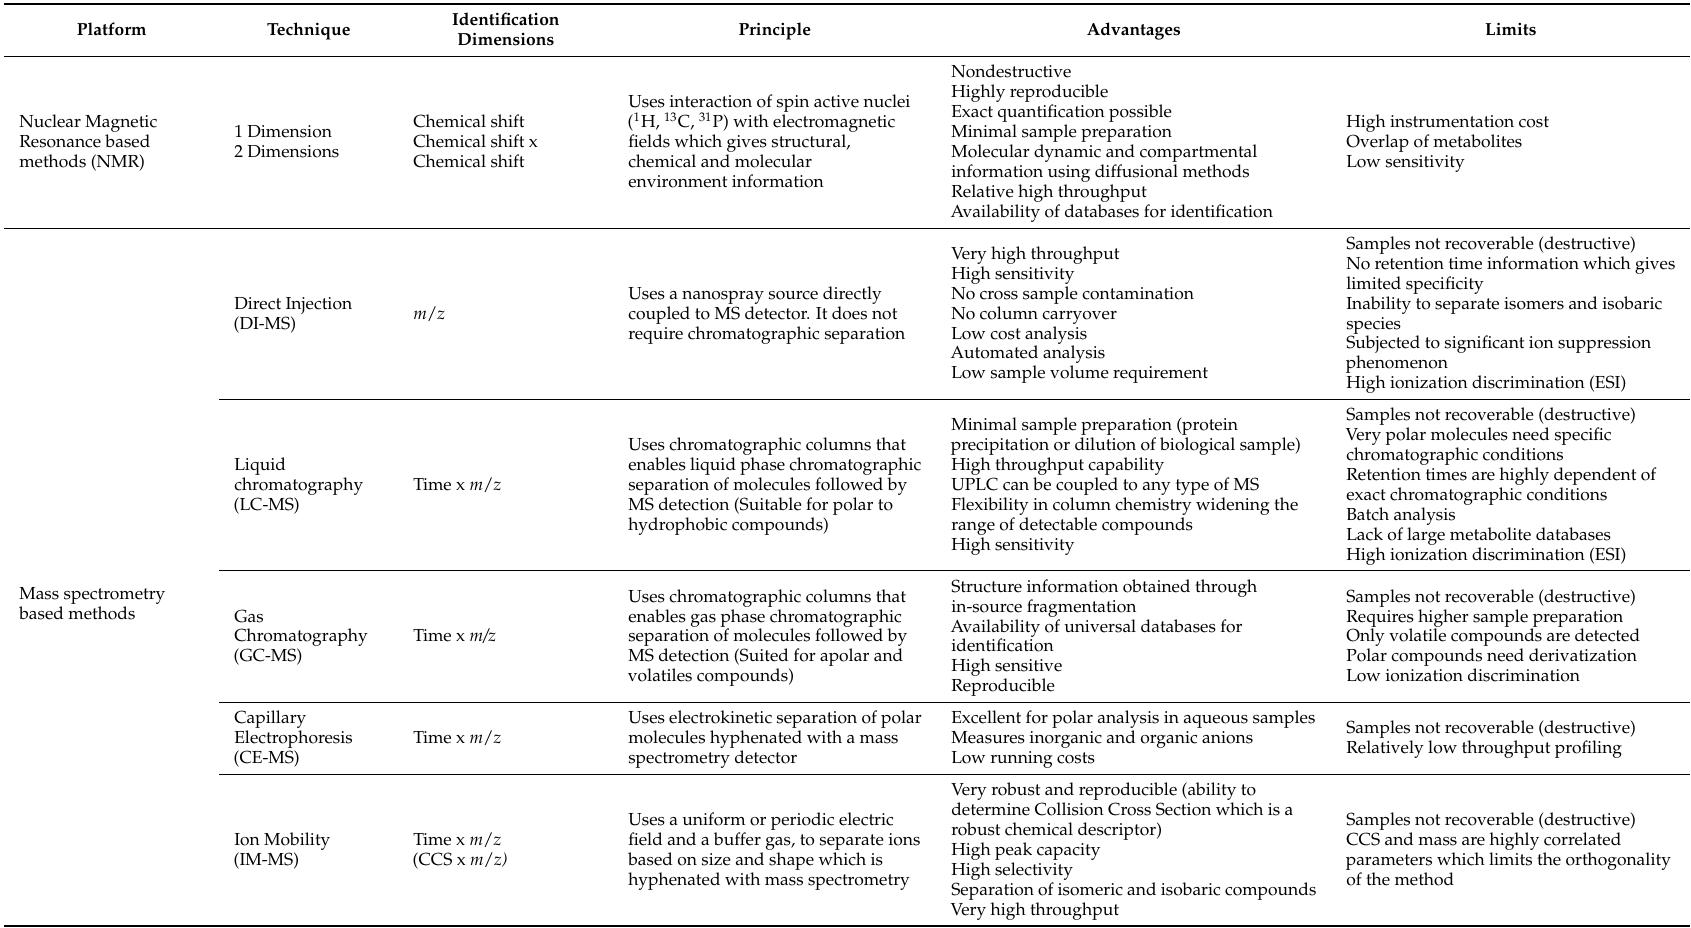
Table 1. Comparison of main metabolomics analytical technologies with particular potential in inborn errors of